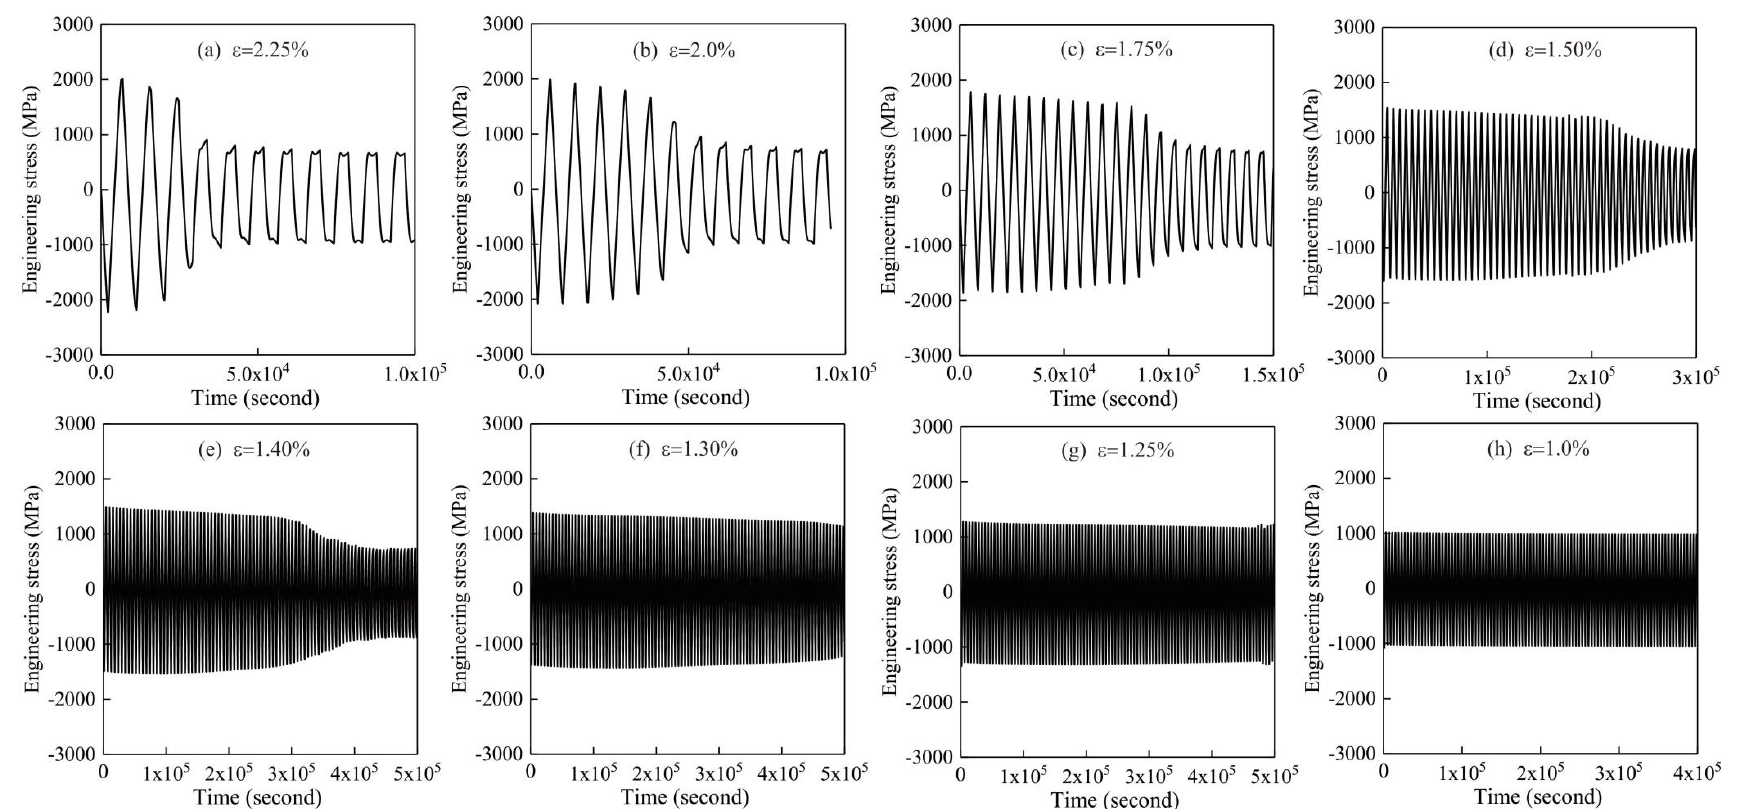
Figure 5. Correlation of engineering stress along with time under different strain amplitudes. ( a ) ε = 2.25%; ( b ) ε = 2.0%; ( c ) ε = 1.75%; ( d ) ε = 1.50%; ( e ) ε = 1.40%; ( f ) ε = 1.30%; ( g ) ε = 1.25%; ( h ) ε = 1.0%.